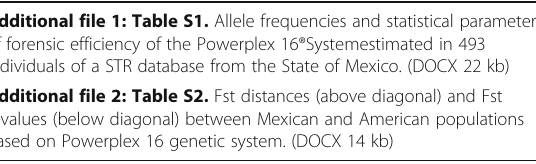
based on Powerplex 16 genetic system. (DOCX 14 kb)